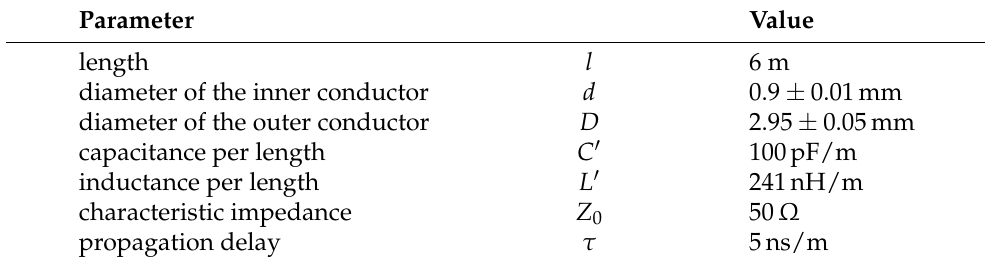
Table 1. Parameters of the coaxial cable RG 58 C/U